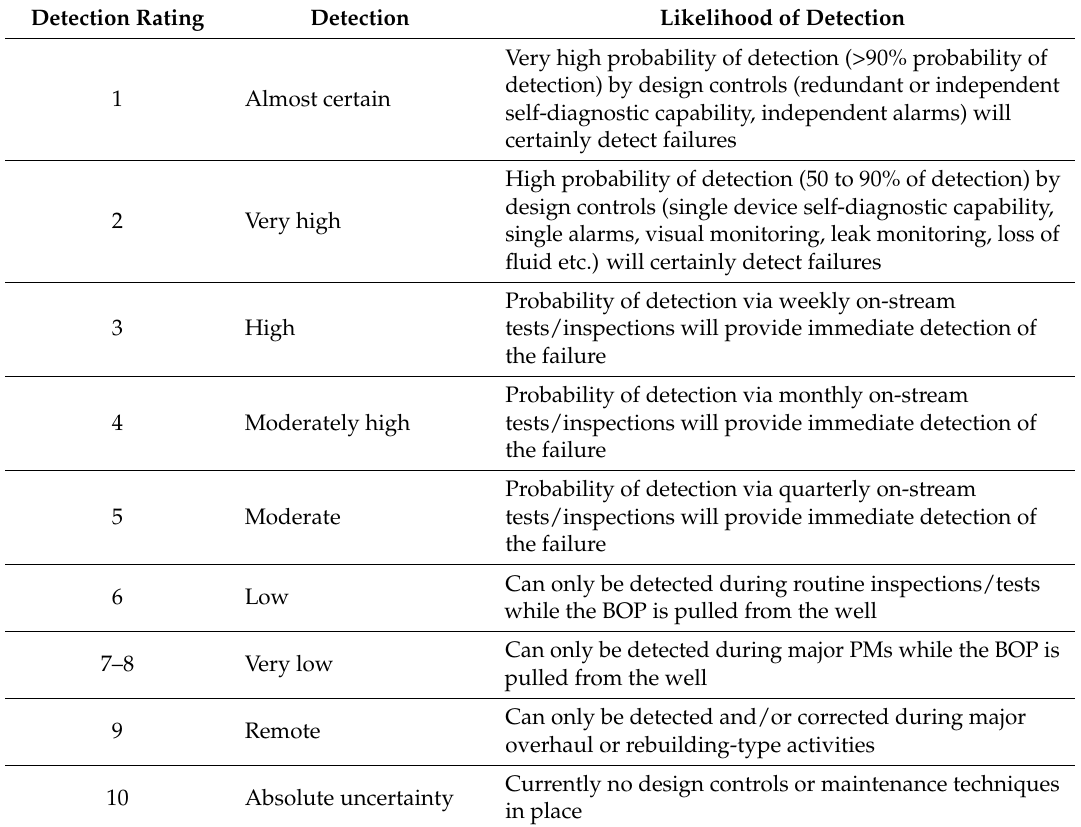
Table 6. Detectability ratings of a failure for BOP.